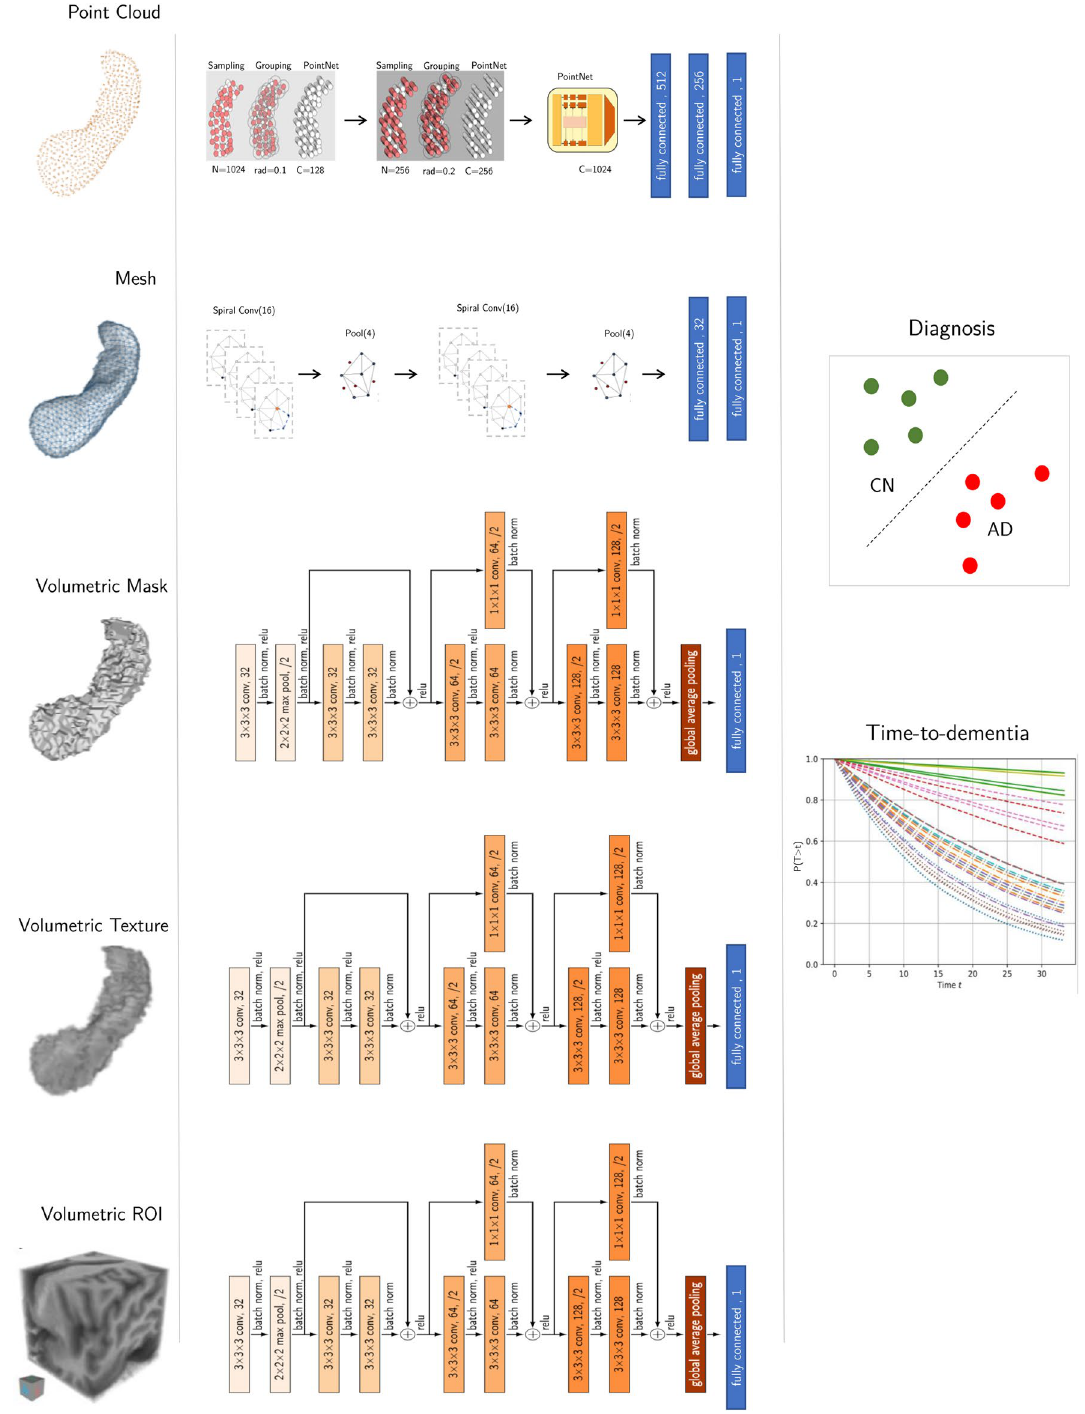
Figure 1. Evaluation scheme overview. Left column shows the different ways of representing the hippocampus. Middle column describes the different model architectures. The right column defines the two tasks that we evaluated in this study: diagnosis and